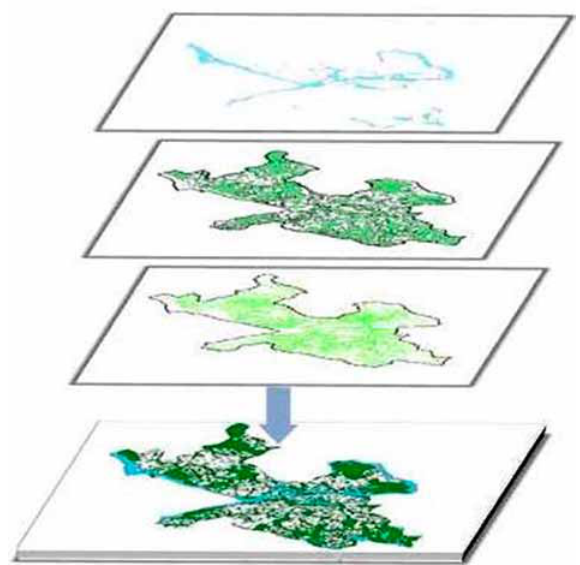
fig. 8. The structure of the Stockholm green